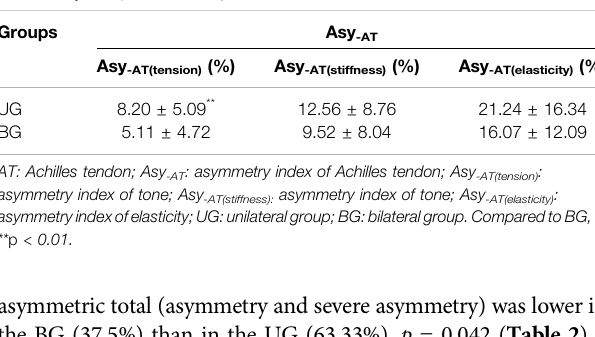
TABLE 3 | Comparison of Asy -AT between UG and BG. Groups Asy -AT Asy -AT(tension) (%) Asy -AT(stiffness) (%) Asy -AT(elasticity)